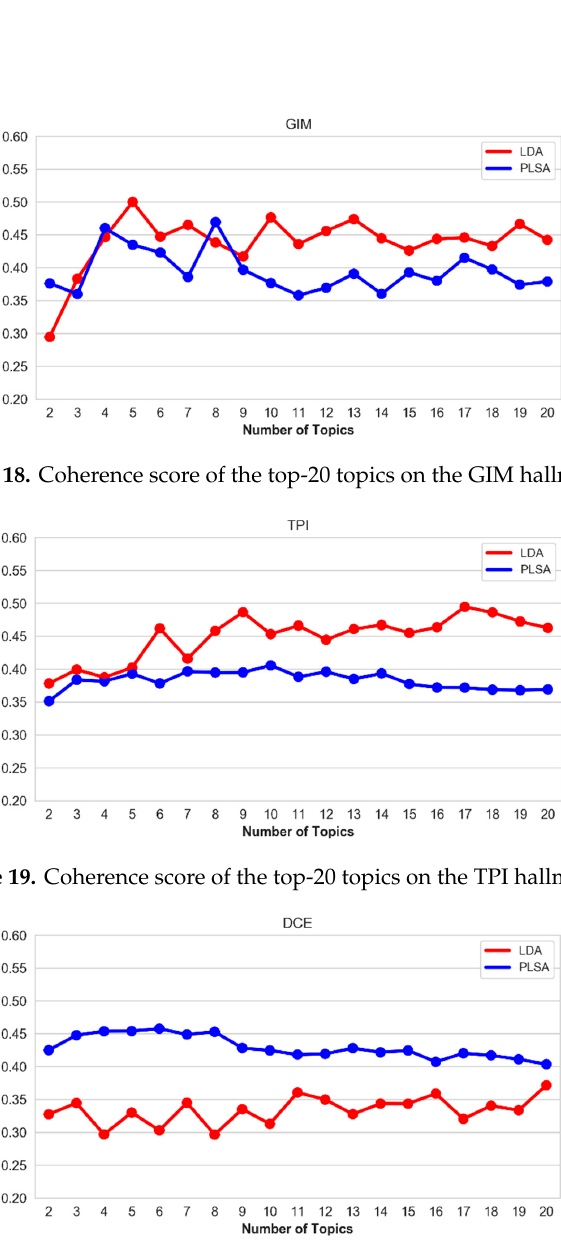
Figure 20. Coherence score of the top-20 topics on the DCE hallmark.